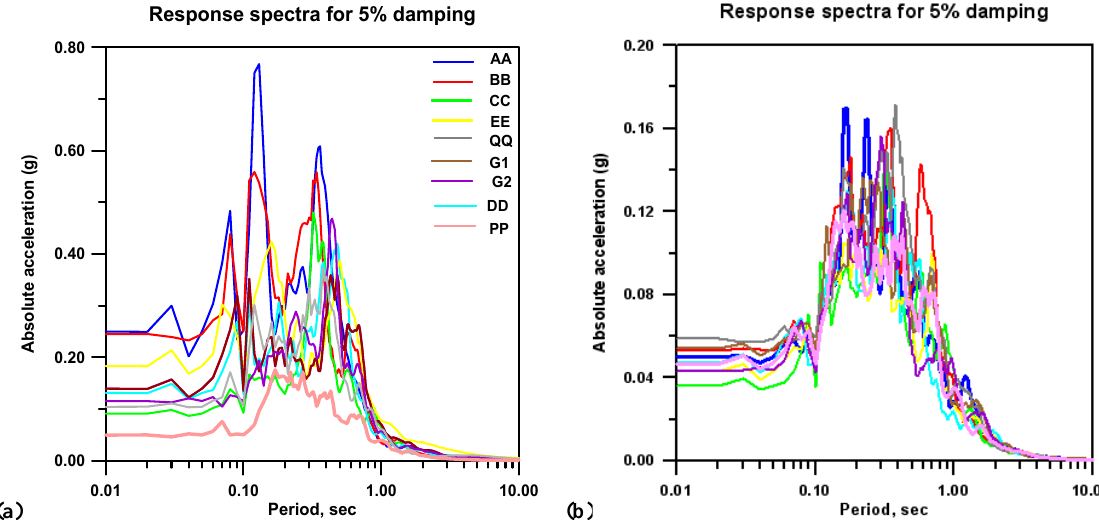
Fig. 10. Acceleration response spectra at the nine investigated sites (a, c for predicted surface motion and (b, d) base (input) motion for the scenario earthquake of M = 6 . 3 on the Epidaurus fault.